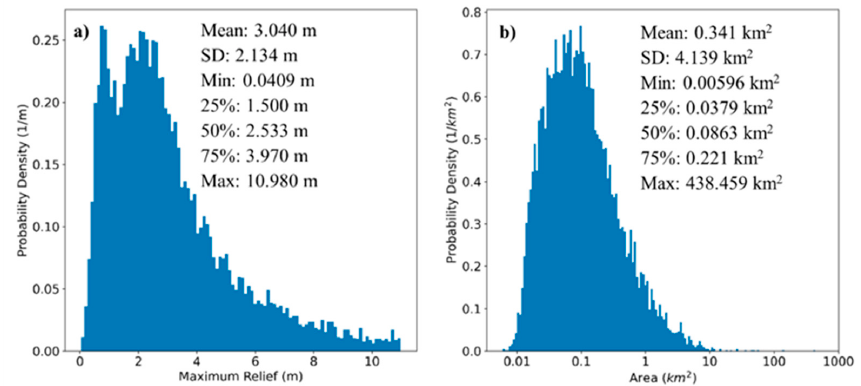
Table 3. Area, max. relief, and length to width ratio middle quartiles for subsets of the Carolina Bay detections.